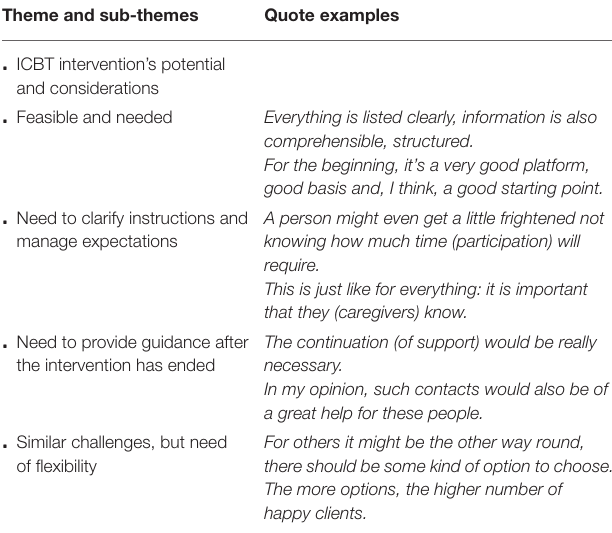
TABLE 6 | Selected examples of focus group participant